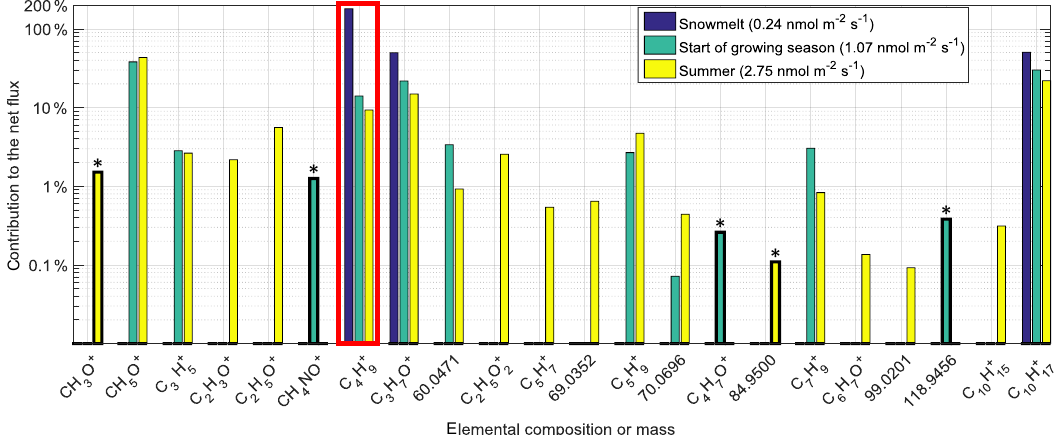
Figure 3. Contribution of each compound to the 24h average net flux of the respective month. Bars with thick outlines and ∗ above them correspond to negative fluxes, where the absolute value was taken before plotting them in the logarithmic scale. See Table 1 for corresponding compound names. Emissions of C 4 H + are highlighted with a red box as they are anthropogenic (Sect. 3.4) and, therefore, are not included 9 in the net